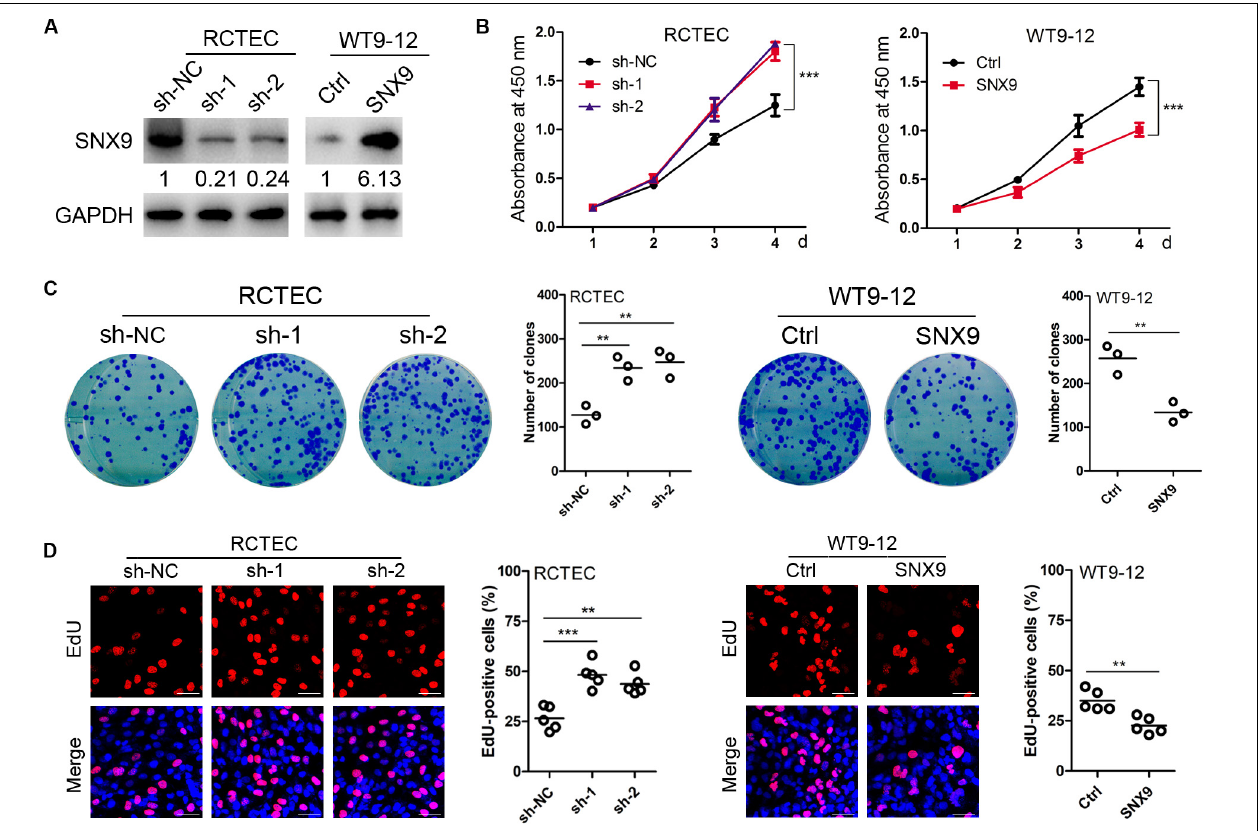
FIGURE 2 | SNX9 inhibits ADPKD cell proliferation. (A) Effects of SNX9 overexpression and silencing were examined by Western blot analysis. (B) CCK-8 assay, using the indicated cells with modified SNX9 expression levels. ***Indicates P < 0.001 by Student’s t -test, n = 5. (C) Cell colony formation assay, using the indicated cells with modified SNX9 expression levels. Data are presented with scatterplots and mean values; n = 3. **Indicates P < 0.01 by Student’s t -test. (D) The indicated cells, with modified SNX9 expression levels, were subjected to EdU incorporation assay. Representative micrographs and the quantification of EdU labeling in the indicated cells are shown. Data are presented with scatterplots and mean values; n = 5. **Indicates P < 0.01; ***Indicates P < 0.001 by Student’s t